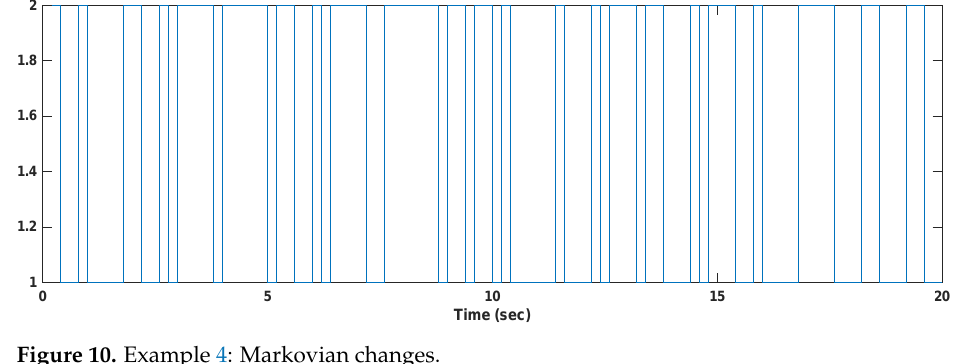
Figure 10. Example 4: Markovian changes.